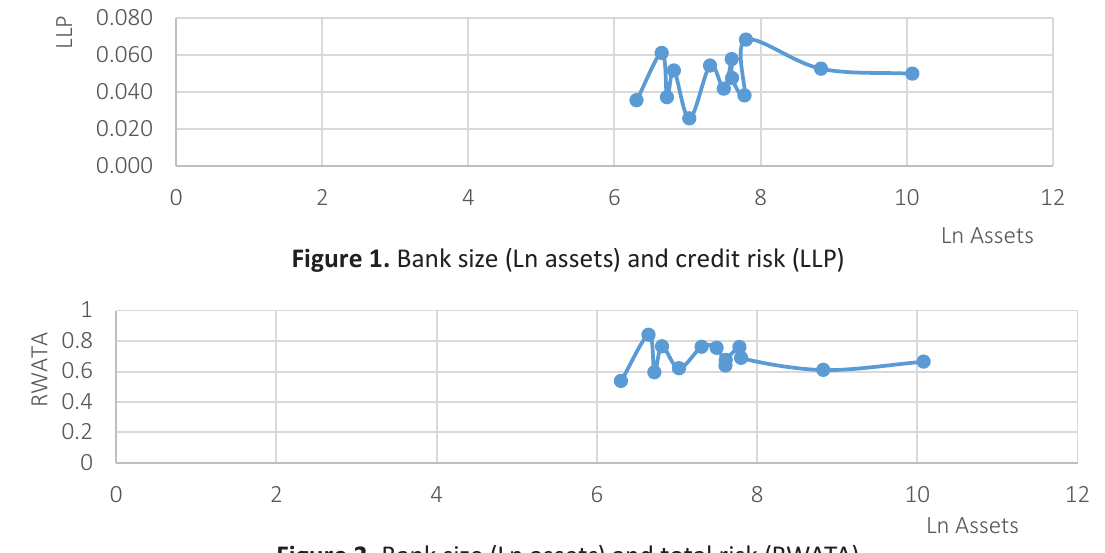
Figure 2. Bank size (Ln assets) and total risk (RWATA)